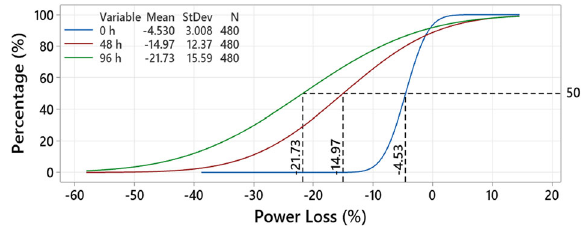
Fig. 5 Cumulative distribution function of all measured samples. The horizontal dashed line at 50% corresponds to the mid-range of the percentile.